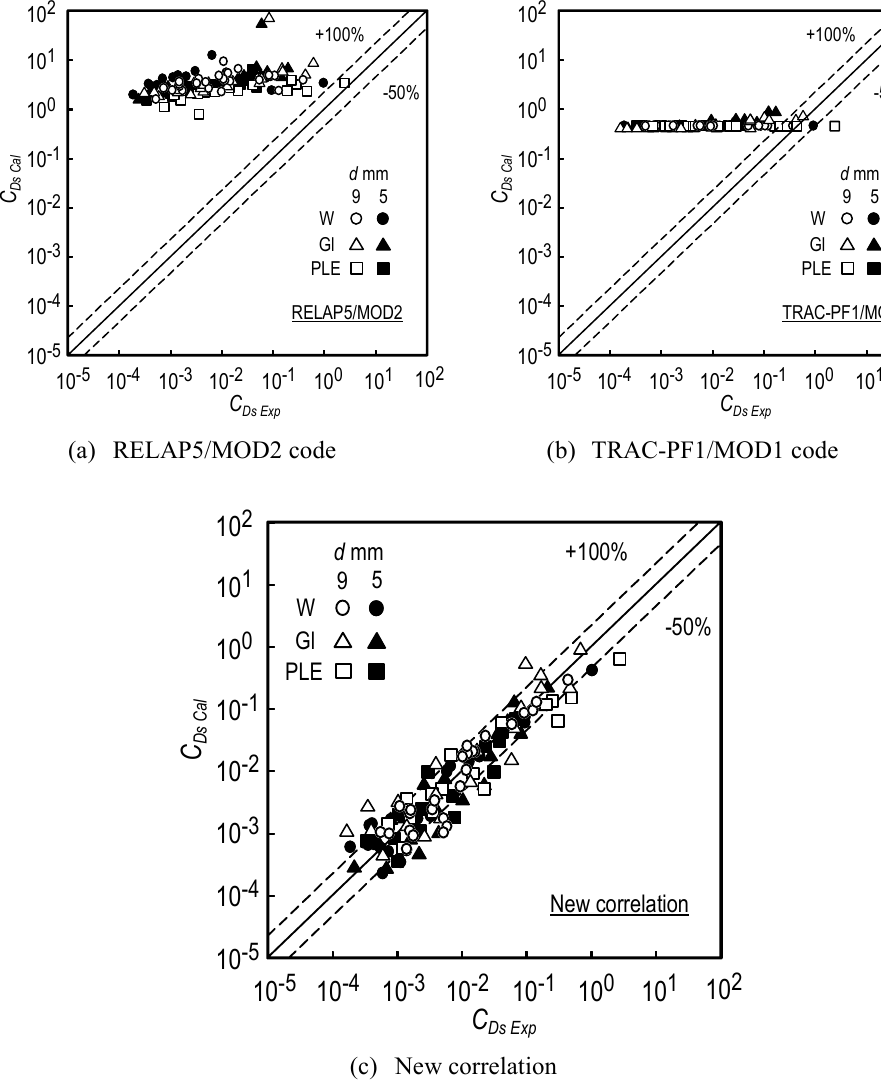
Fig. 4 Comparisons of drag coefficient for large bubble in slug flow between experiment and